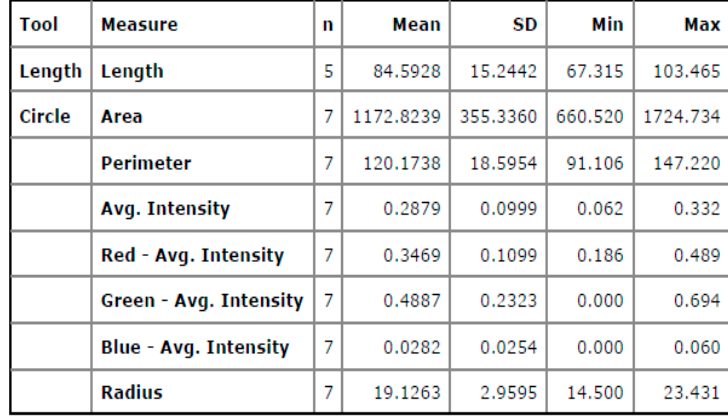
Figure 15. Screen shot of the statistical measurements of the segments at the fractured surface.